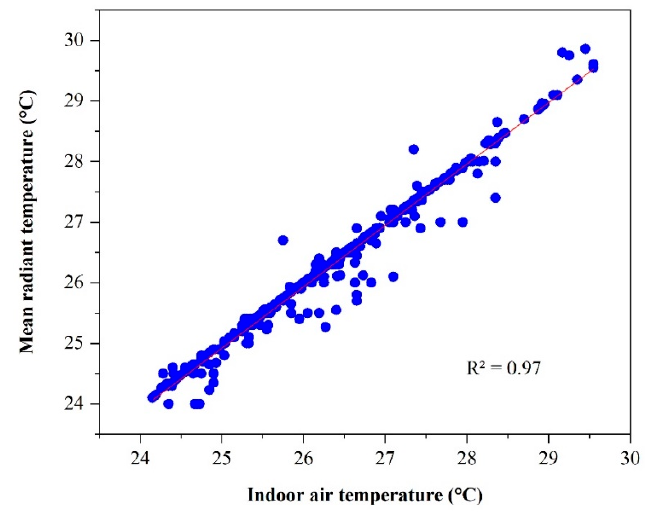
Figure 12. Relationship between mean radiant temperature (T r ) and indoor air